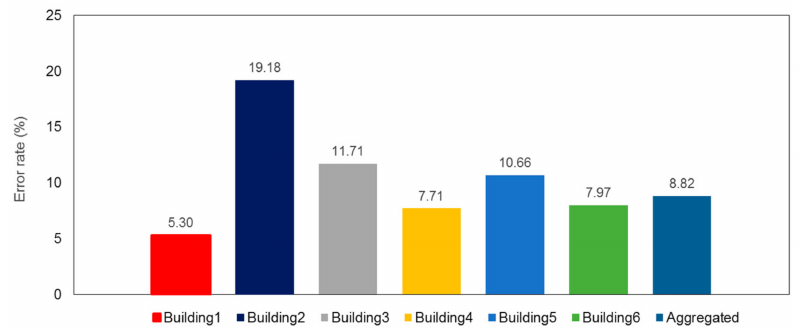
Figure 14. Average percentage error results for spring season.